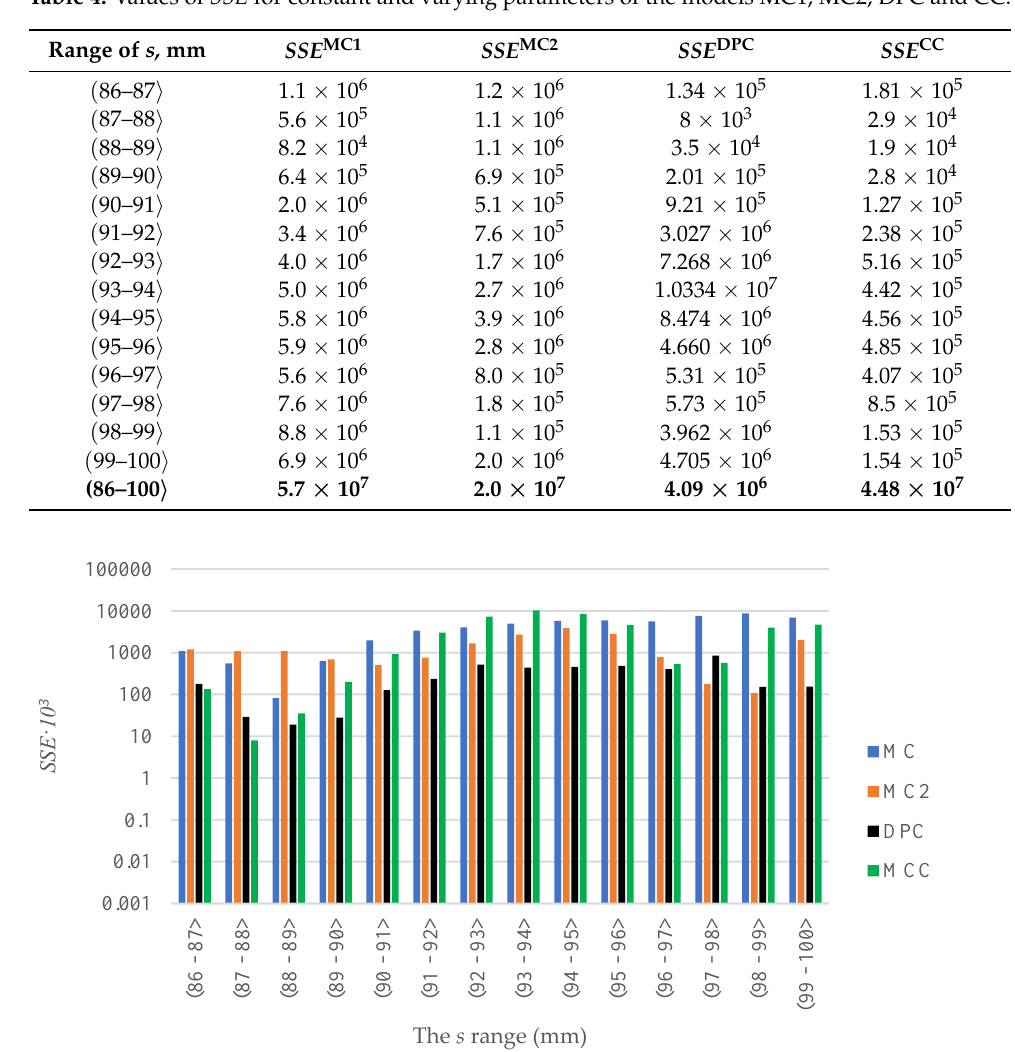
Table 4. Values of SSE for constant and varying parameters of the models MC1, MC2, DPC and CC.